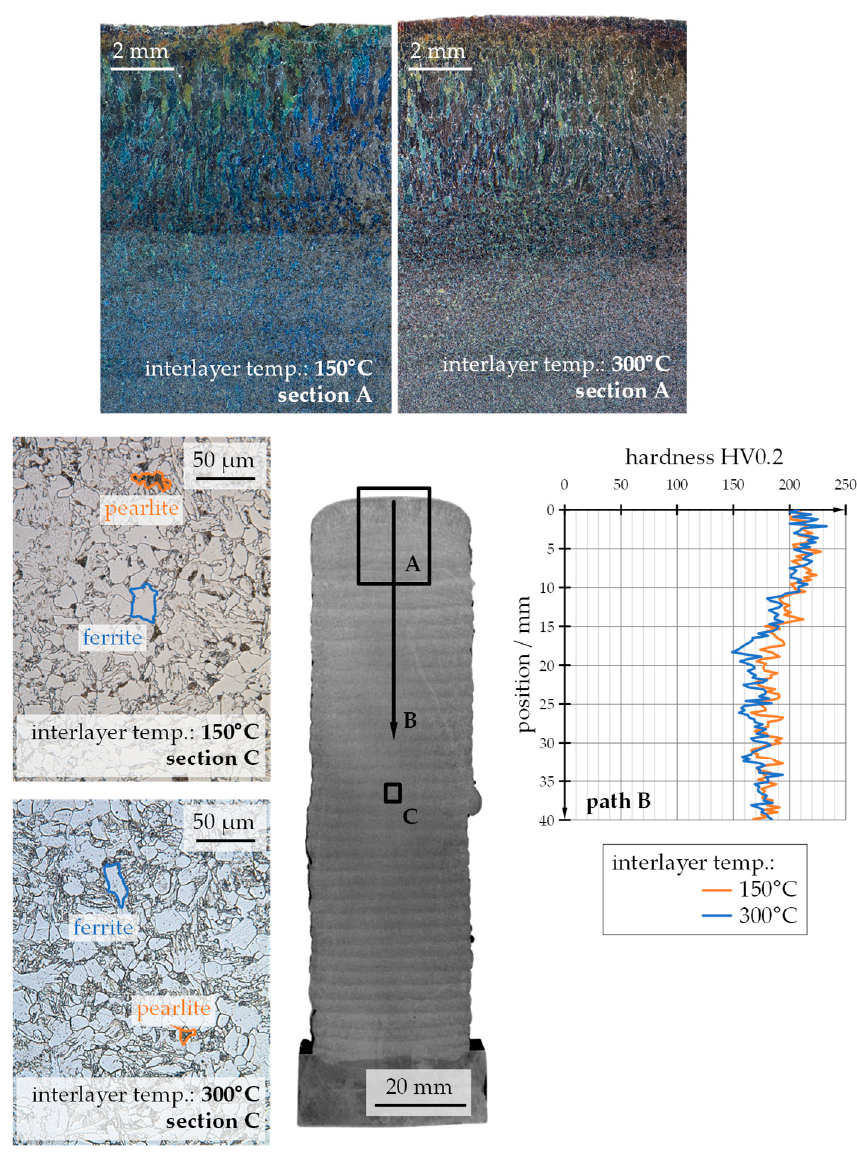
Figure 5. Micrographs and hardness measurements of cross-sections of WAAM material for interlayer temperatures of 150 and 300 °C.